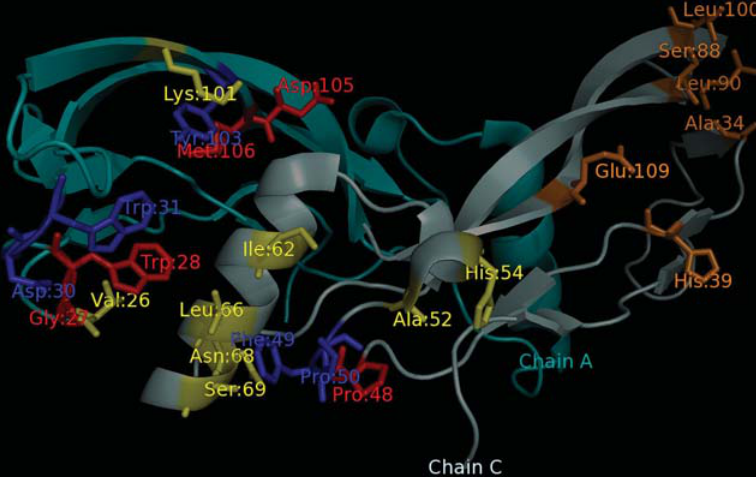
Figure 3 - Homodimeric molecule of bone morphogenetic protein-2 (BMP-2) (1es7:A and C). For the larger epitope (left), true positives are indicated in blue, false positives in red and false negatives in yellow. Residues in the smaller epitope (right) are indicated in